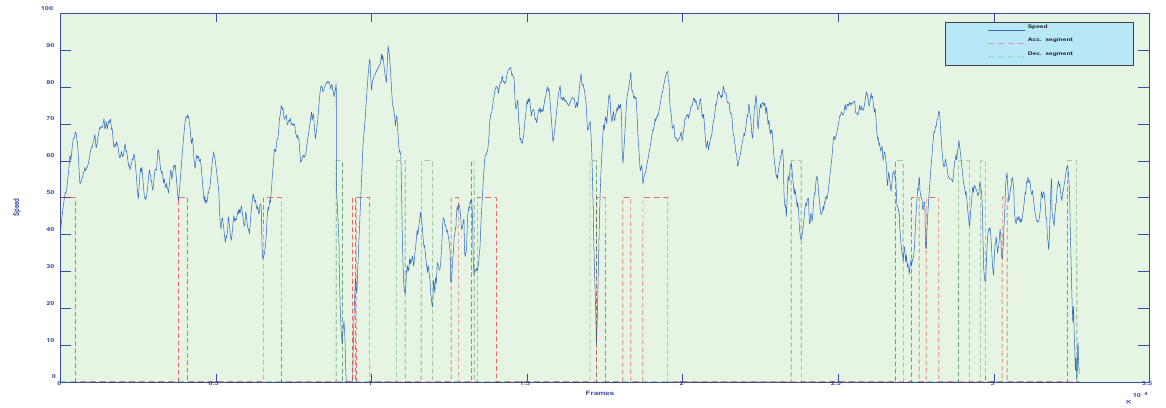
Figure 8 Acceleration and deceleration segment label